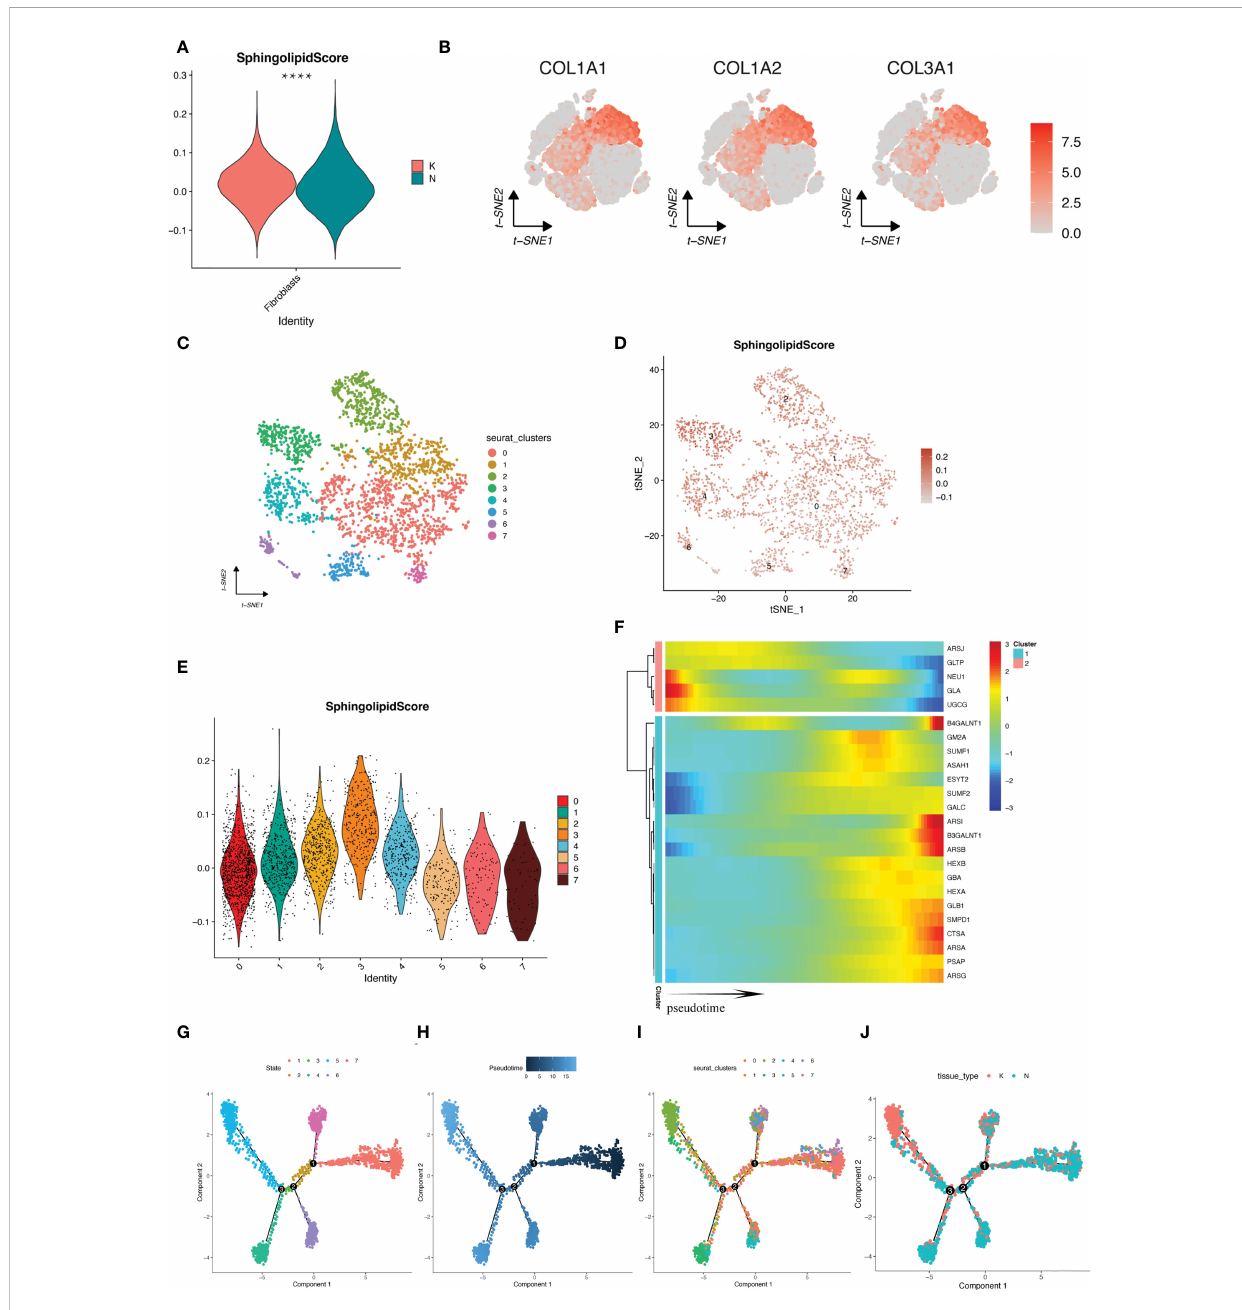
FIGURE 8 Progression of fi broblast cell pro fi les revealed by pseudotime analysis. (A) GSL metabolic pathway scores of fi broblasts in keloid and NS. (B) tSNE plots showed the expression of marker genes in fi broblasts. (C) Fibroblasts were clustered again by downscaling and shown by tSNE plots. (D) tSNE plots of the GSL metabolic pathway scores of individual fi broblasts. (E) The GSL metabolic pathway scores of the fi broblast subpopulations that were downscaled again. (F) Heatmap showing the expression changes of genes in GSL metabolic pathway with fi broblast differentiation. (G – J) Trajectory differentiation maps according to cell differentiation status, cell development time coloring, cell cluster and tissue type. ****p <